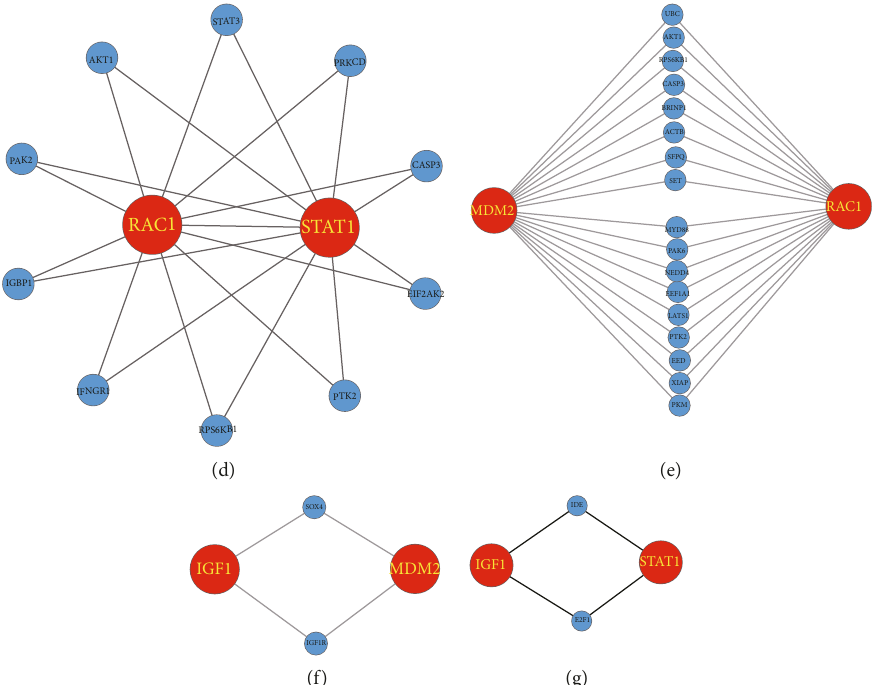
Figure 2: The protein-protein interaction network for MDM2, IGF1, STAT1, and RAC1. (a) MDM2, IGF1, STAT1, and RAC1 are hub proteins in the PPI network as they have hundreds of interacting proteins. (b) MDM2, IGF1, STAT1, and RAC1 are connected by at least two or more shared interacting proteins. (c – g) The interactions of every two genes between MDM2, IGF1, STAT1, and